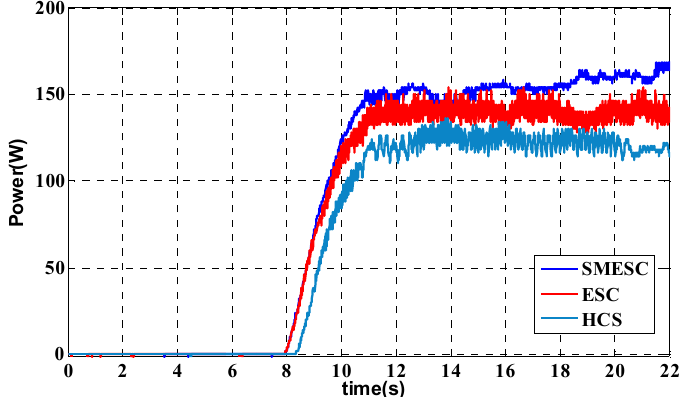
Figure 18. Waveform of measured output power for the three different control algorithms under fixed wind speed conditions.